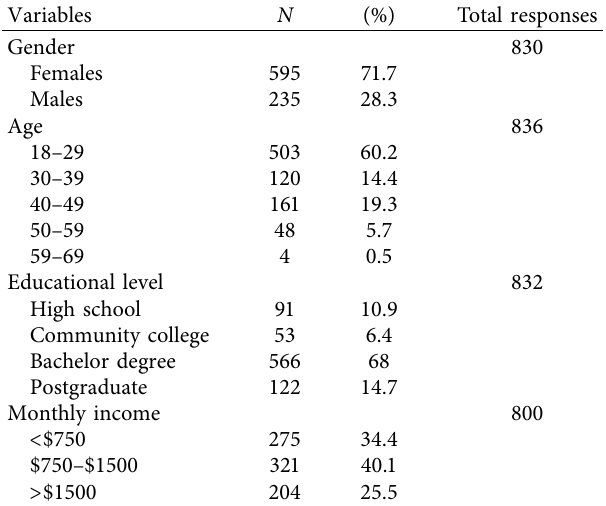
Table 1: Demographic characteristics of the